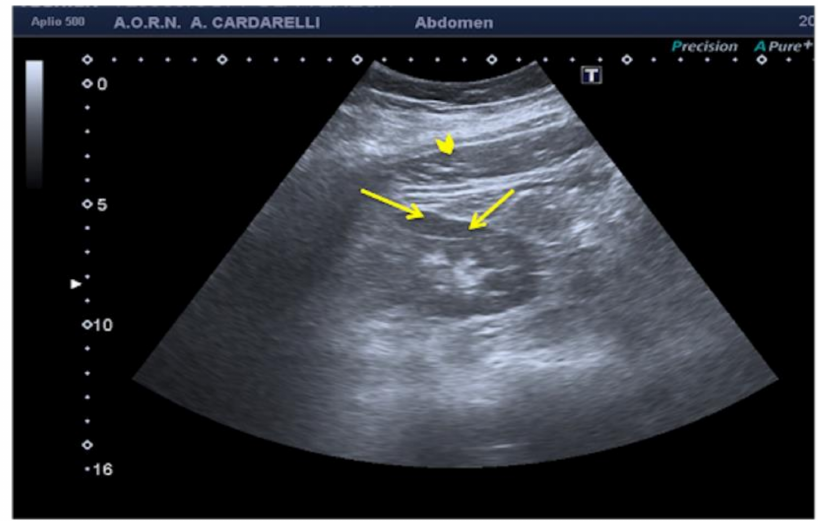
Figure 11. Coronal images of the right kidney. A reverberation artifact from strong echoes of the abdominal wall (arrowhead) projects over the lateral margin of the kidney, mimicking the presence of a subcapsular hematoma (arrows).